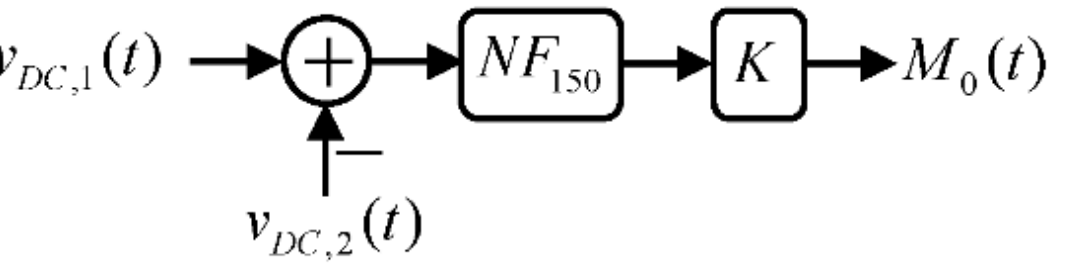
Figure 5. Generation of zero-sequence component M 0 ( t ).